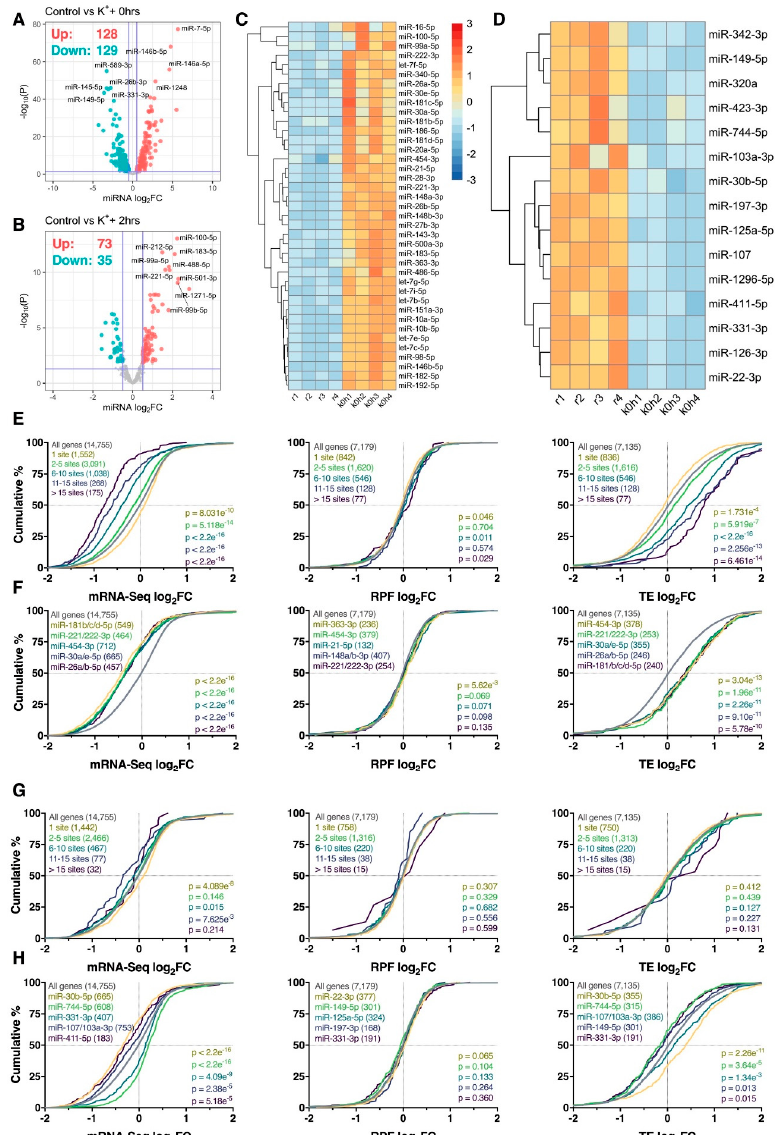
Figure 6. Neuronally enriched miRNAs are associated with changes in mRNA abundance. ( A , B ) Volcano plots comparing log 2 fold change (log 2 FC) and –log 10 p -values of mature miRNAs immediately ( A ) or 2 h ( B ) after depolarization, relative to resting cells. Significantly upregulated and downregulated miRNAs are marked in red and blue, respectively, with Benjamini–Hochberg FDR < 0.05 and log 2 fc > | ± 0.5 | considered significant. Horizontal line represents nominal p < 0.05. ( C ) Heat map depicting expression of 39 miRNAs significantly upregulated immediately after the depolarization paradigm and within the top 20% of brain-expressed miRNAs as reported by the miRMine database [31]. Each cell corresponds to the counts per million (CPM) standard deviation relative to the row-wise mean, with red corresponding to high expression, and blue to low expression. ( D ) As in ( C ), except depicting the expression of 15 significantly downregulated and brain-enriched miRNAs. Note that panels ( C ) and ( D ) share the same scale. ( E ) Cumulative density plots of mRNAs collectively targeted by the miRNAs are presented in panel ( C ), stratified by the number of expressed miRNA binding sites. Groups were compared to the entire transcriptome via two-sided Kolmogorov–Smirnov test, with p -values (and number of genes analyzed) reported (bottom right). ( F ) As in ( E ), except after analyzing the target genes of each miRNA individually. Top 5 miRNAs ranked via p -value are shown. In the case of p -value ties, miRNAs with the largest median di ff erence relative to the transcriptome are shown. ( G , H ) As in ( E , F ), except analyzing the target genes of miRNAs depicted in panel ( D